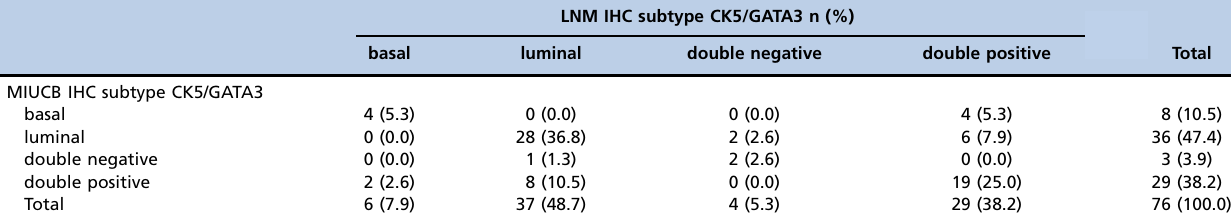
Table 5 - Comparison of the IHC subtypes obtained in the MIUCB and in the respective LNM using CK5 and GATA3.